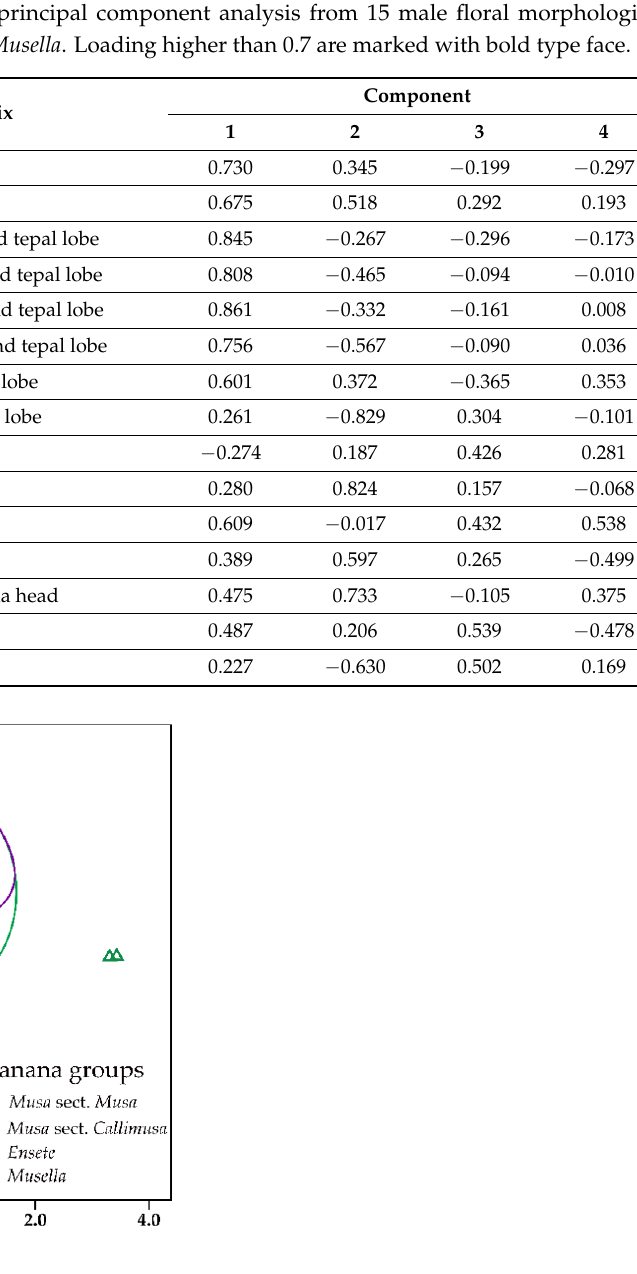
Figure 1. Scatter plot of the first two principal components based on 15 male flower traits from 59 OTUs of Musaceae. Symbol representative group of Musaceae: triangle, Musa + Rhodochlamys ; cross, Callimusa + Australimusa ; circle, Ensete and filled square, Musella . Canonical Discriminant Analysis (CDA) provided 100% of the variation between the three genera in the first two dimensions (Table 3, Figure 2). The results of the CDA indicated that the characters most significantly separated flowers of Ensete from Musa and Musella were, i.e., length from style base to stigma head, width of ovary, length of median inner tepal, length of filament and length of ovary (Table 4—Function 1). The characters that separated Musella from Ensete and Musa includes length of compound tepal, length of anther, width of lateral outer compound tepal lobe, width of compound tepal, length of inner compound tepal lobe, width of central outer compound tepal lobe, width of inner compound tepal lobe, length of central outer compound tepal lobe and width of median inner tepal (Table 4—Function